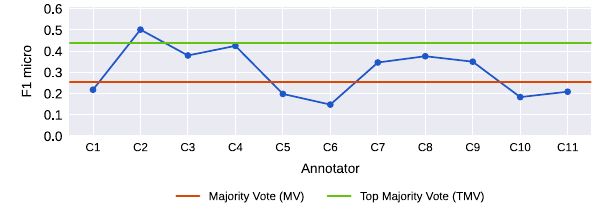
Fig. 7 Multiclass random forest QEUH models, run on the HiRID external validation dataset. Majority Vote (MV) refers to a total majority-vote consensus model. Top Majority Vote (TMV) was built from the majority-vote labels across the top-performing consultant